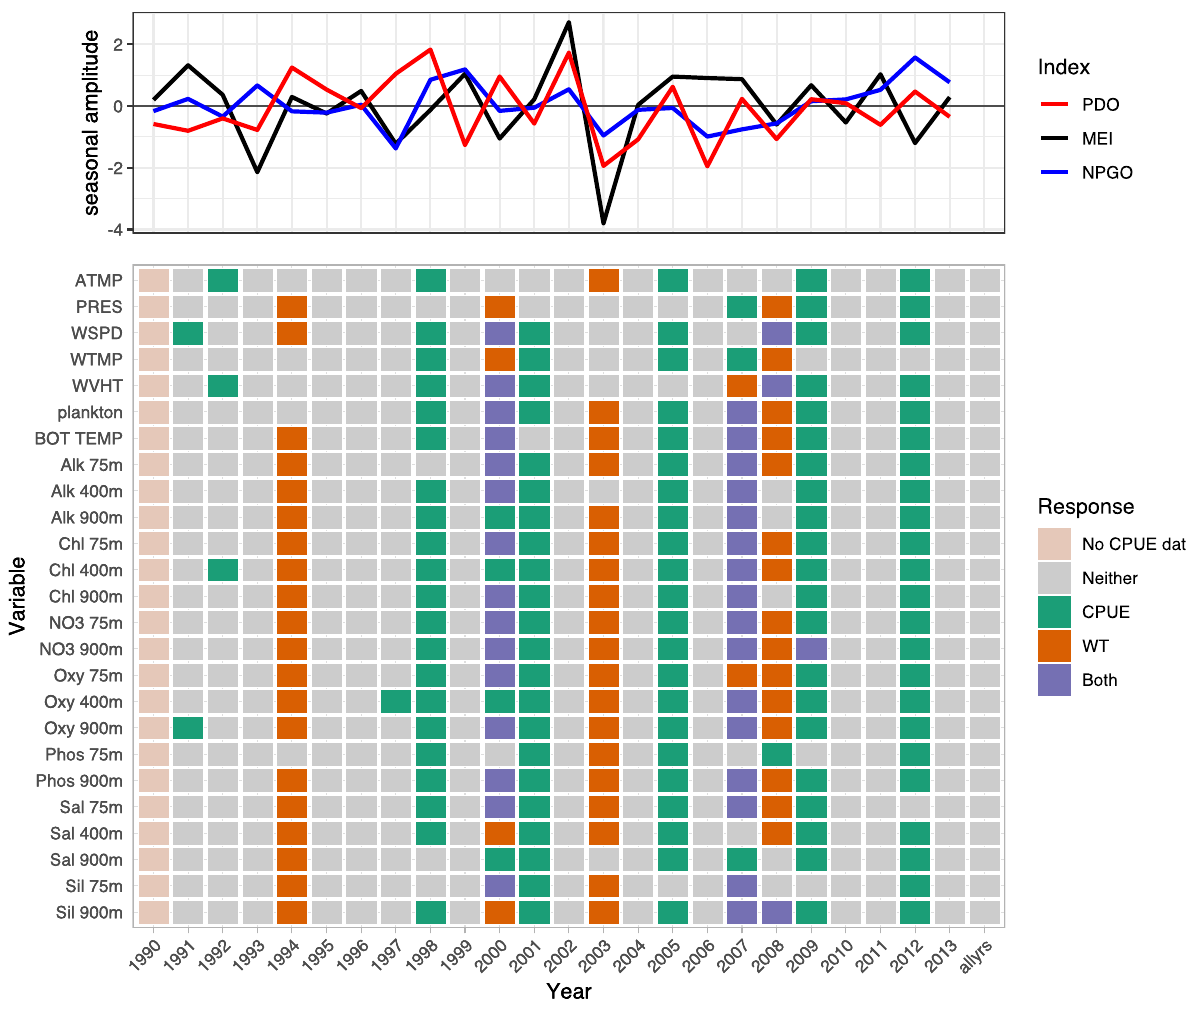
Figure 5. Variable selection analyzed for each available year and all years together for the SIVCMs with shortraker rockfish CPUE or WT as the response. Axes, colors, and line plot are as described in Fig.